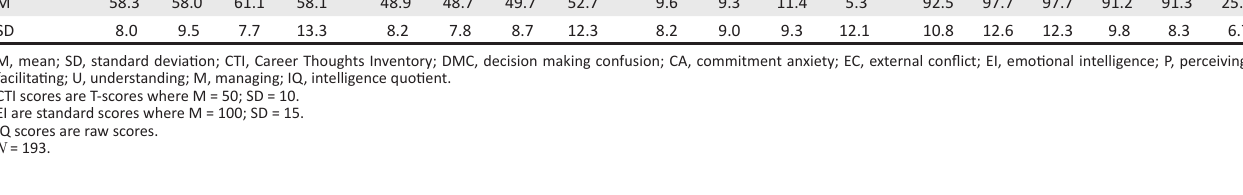
TABLE 1: Means and standard deviations for Career Thoughts Inventory (pre, post and change), emotional intelligence and intelligence quotient. Descriptive statistics